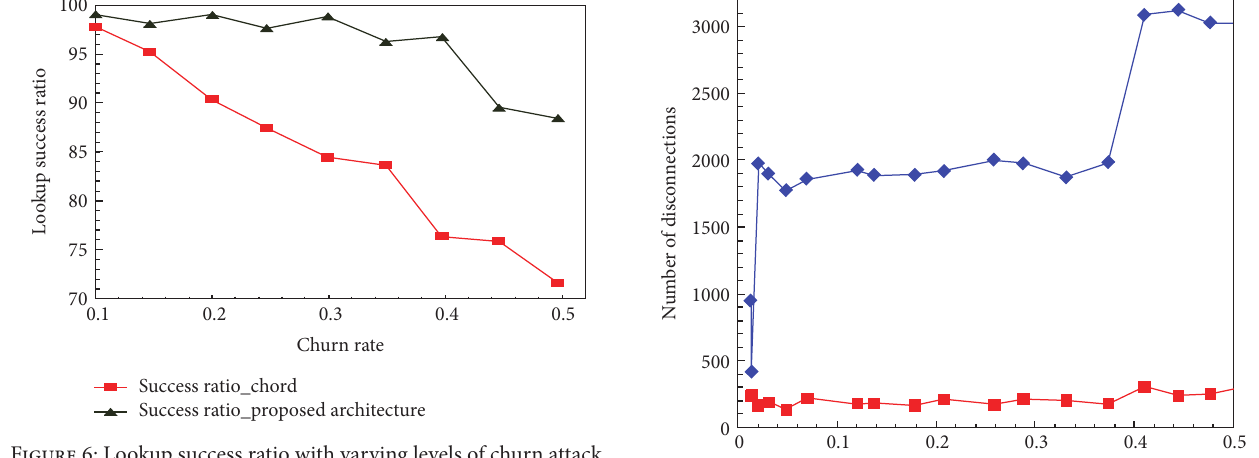
Figure 6: Lookup success ratio with varying levels of churn attack.